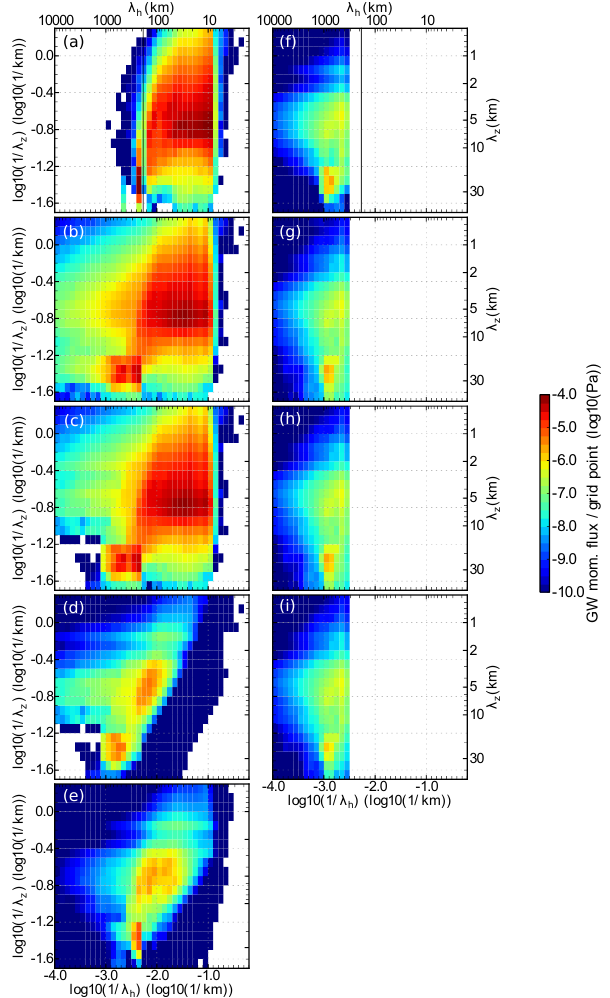
Figure 6. Spectral distributions of MF1 through different steps of the observational filter for January 2008 with the observation geom- etry of SABER, where (a) is the true spectrum, (b) along-LOS spec- trum, (c) λ h restriction spectrum, (d) instrument-sensitivity spec- trum, (e) projection-on-track spectrum, (f) aliasing-effect spectrum, (g) λ z, obs spectrum, (h) λ z restriction spectrum, (i) observed spec- trum (after the additional correction). Black vertical lines in (a) and (f) indicate λ h = 185km. For details, see